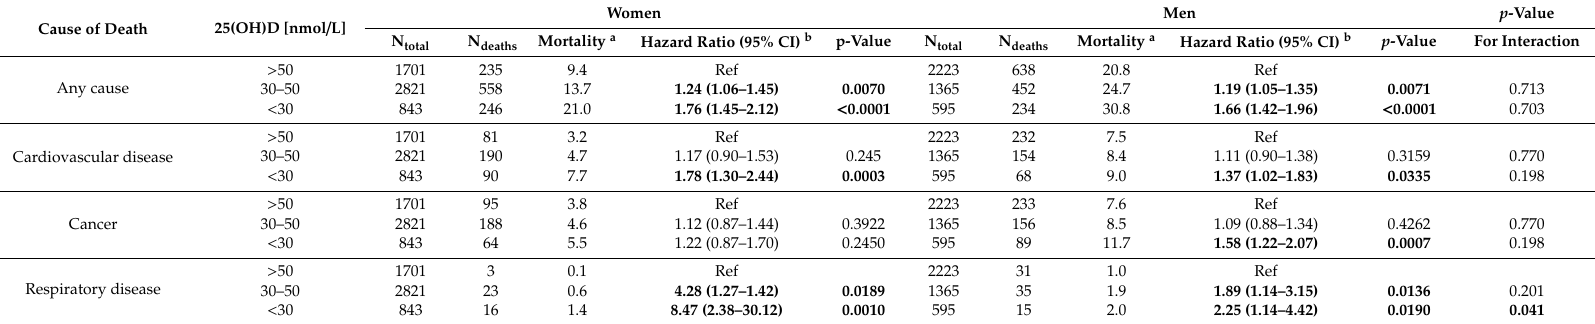
Table 3. Sex-specific analysis on the associations of vitamin D deficiency and insu ffi ciency with mortality from major causes of death. Cause of Death 25(OH)D [nmol / L]